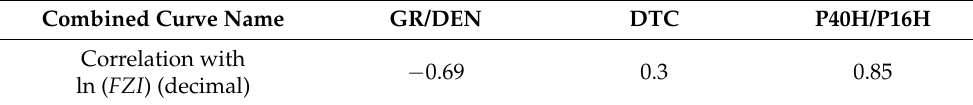
Table 4. Correlation analysis between combination curve and ln ( FZI